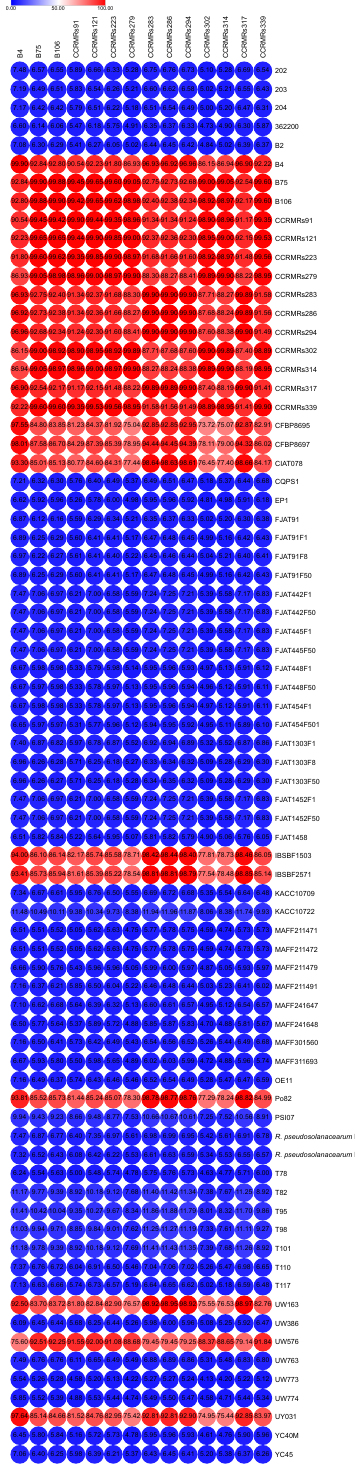
Figure 8. Heatmap representing the in silico DNA–DNA hybridization ( is DDH) of genomes from R. solanacearum species complex (RSSC). The value for each DDH is available inside each